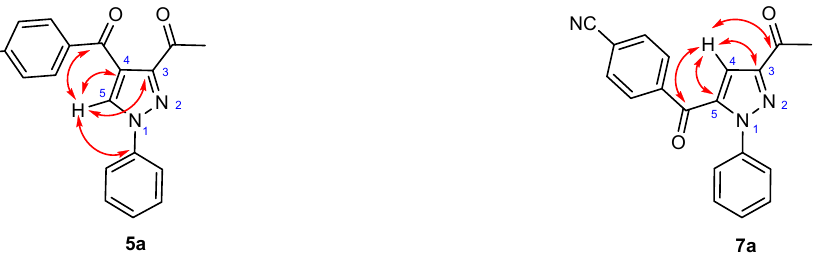
Figure 7. Diagnostic correlations in the 1 H- 13 C HMBC (red arrows) for the two regioisomers 5a and 7a .